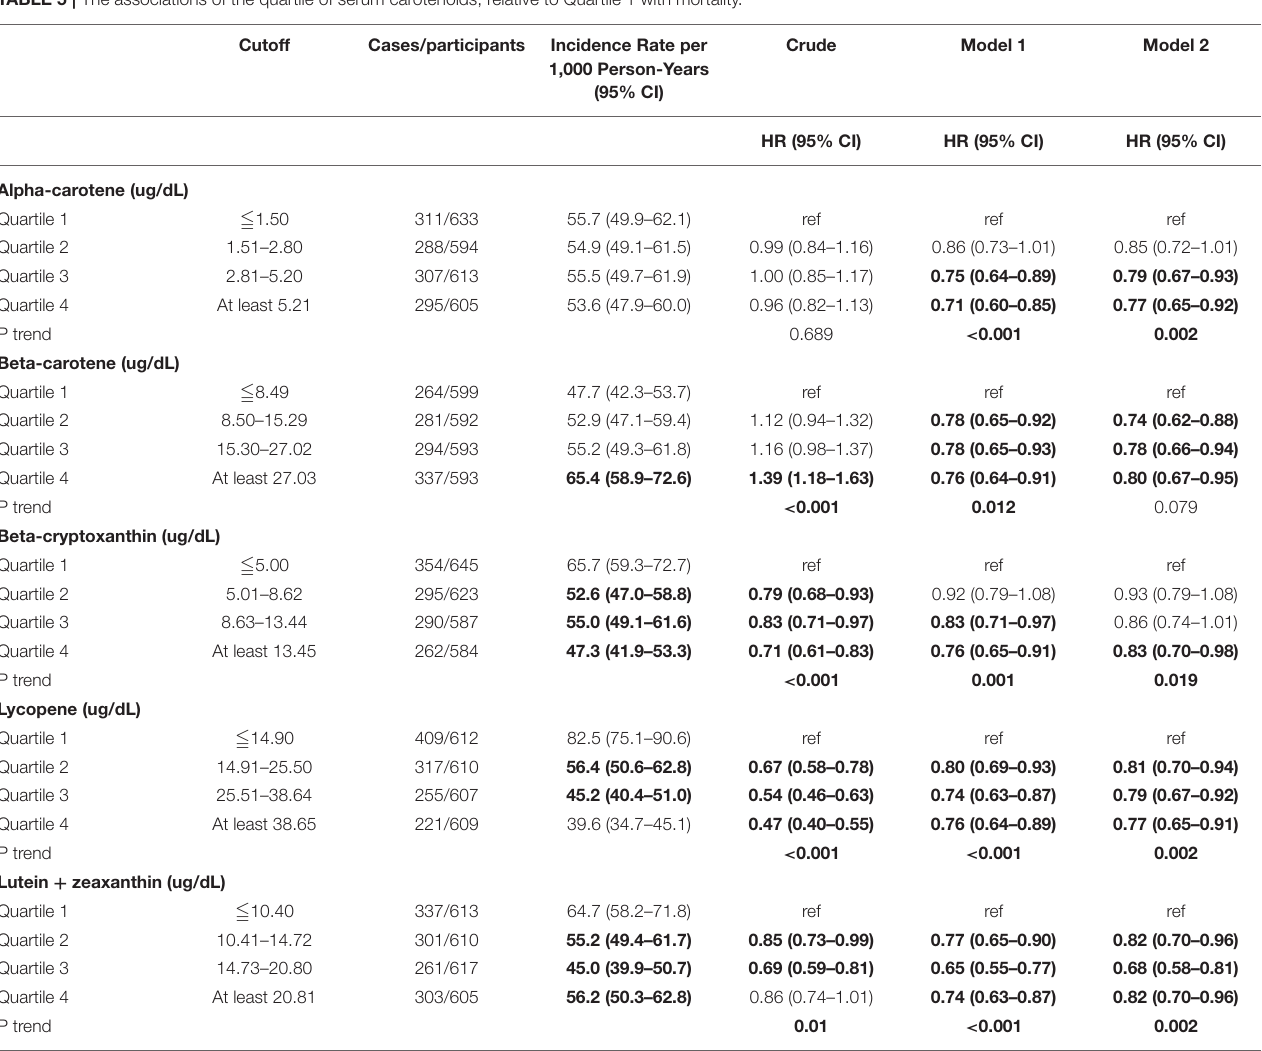
TABLE 5 | The associations of the quartile of serum carotenoids, relative to Quartile 1 with